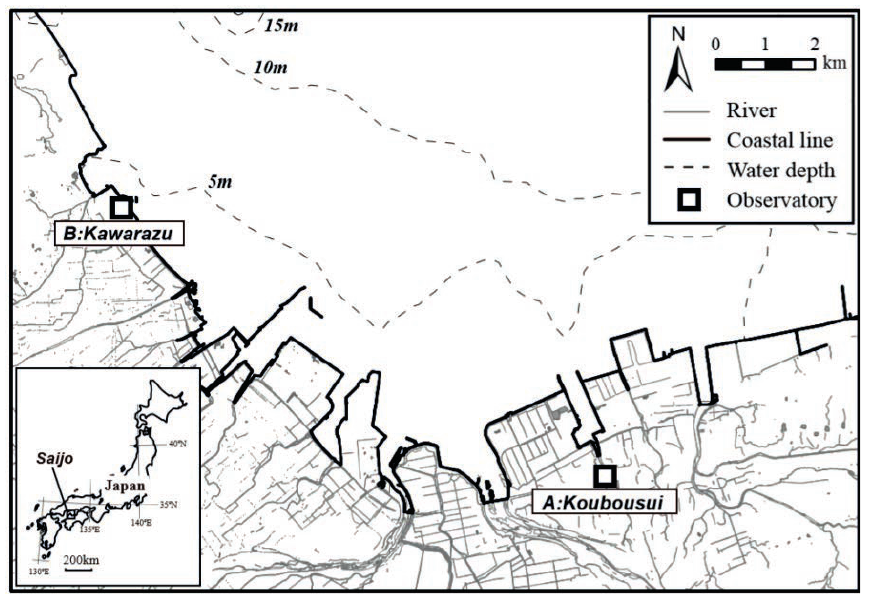
Fig. 1 Location of study area with sites A and